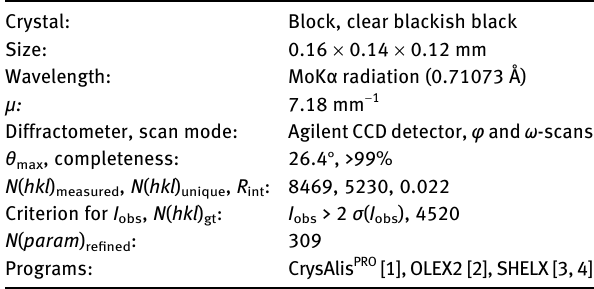
Diffractometer, scan